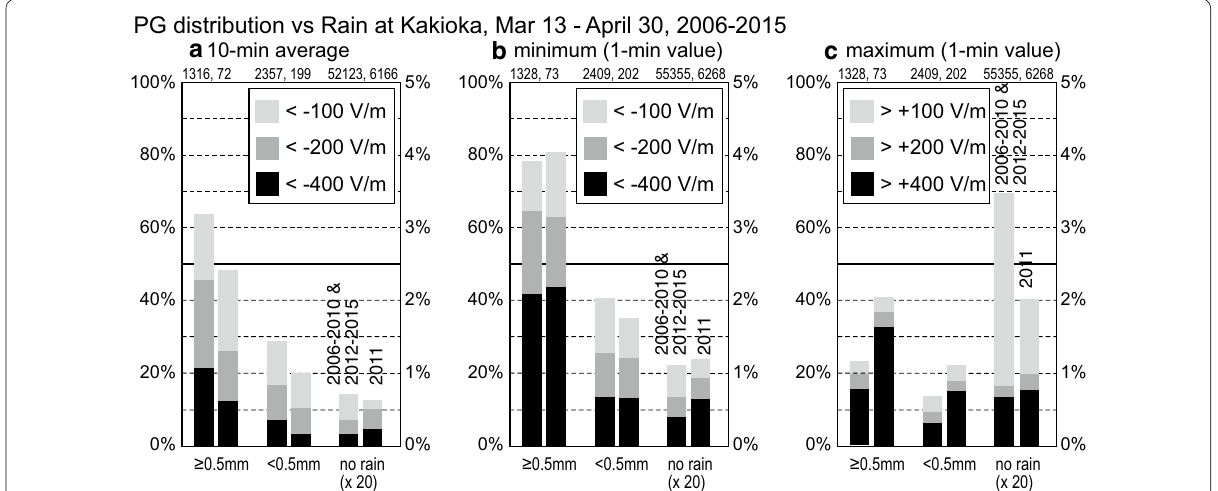
Fig. 3 Observation probability of negative potential gradient (PG) near or during the rain time at Kakioka, 150 km southwest of the Fukushima Dai-ichi Nuclear Power Plant (FNPP1). The 1-min PG date in 10 min bins is used to classify according to a 10-min average, b minute values at nega- tive peak, and c minute values at positive peak, into < − 400 , − 400 to − 200 , − 200 to − 100 , + 100 to + 200 , + 200 to + 400 , and > + 400V/m for different rain conditions: continuous rain ( ≥ 0.5mm ), either light rain ( < 0.5mm ) or within 10 min before the rain, and no rain over 30 min before or after. Since the percentage is very low for no rain cases, the unit is changed in the graph (right axis). The rain record is obtained by an accumulation method every 10 min (see text for detail). The data are compared between immediately after the FNPP1 accident (13 March–30 April, 2011) and the same period (13 March–30 April) at different years (2006–2015). Total numbers of 10-min bins are given at the top of each bar